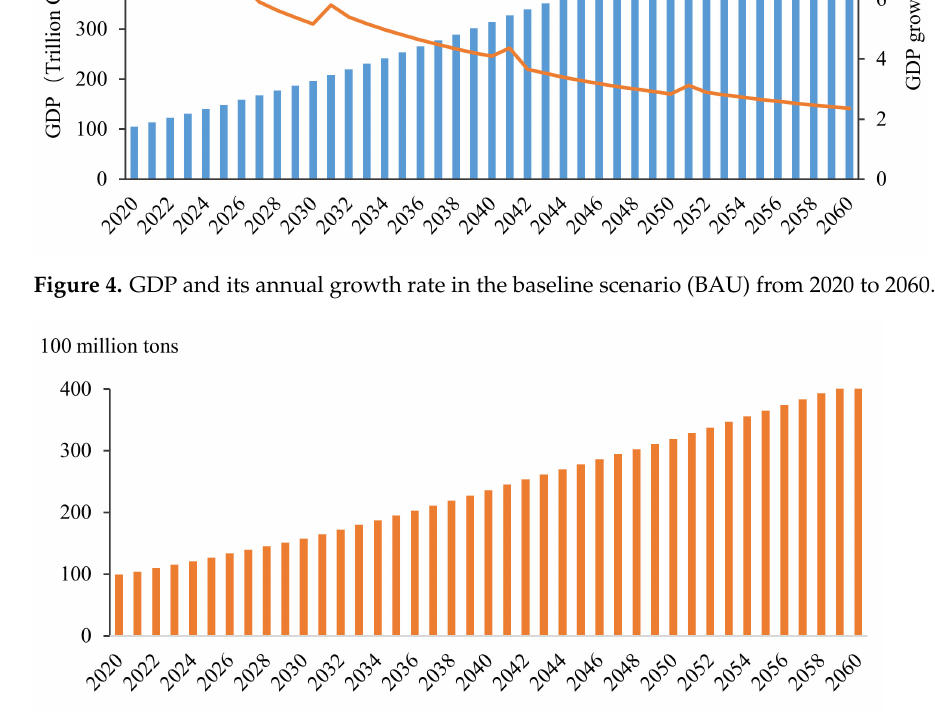
Figure 5. Carbon emissions in the baseline scenario (BAU) from 2020 to 2060.